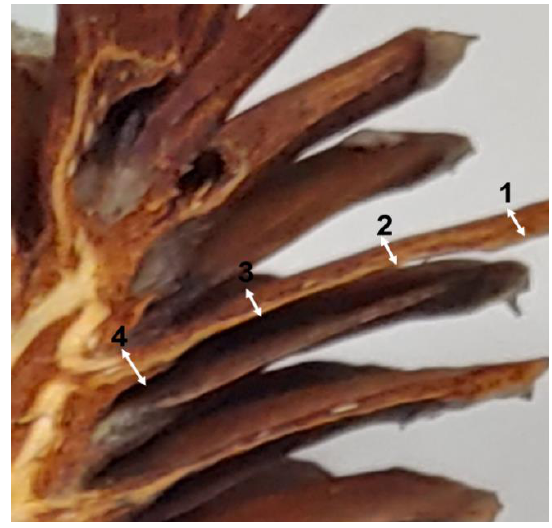
Plants 2020 , 9 , x FOR PEER REVIEW Figure 2. Positions of cone scale to measure the change in thickness. Figure 2. Positions of cone scale to measure the change in thickness.